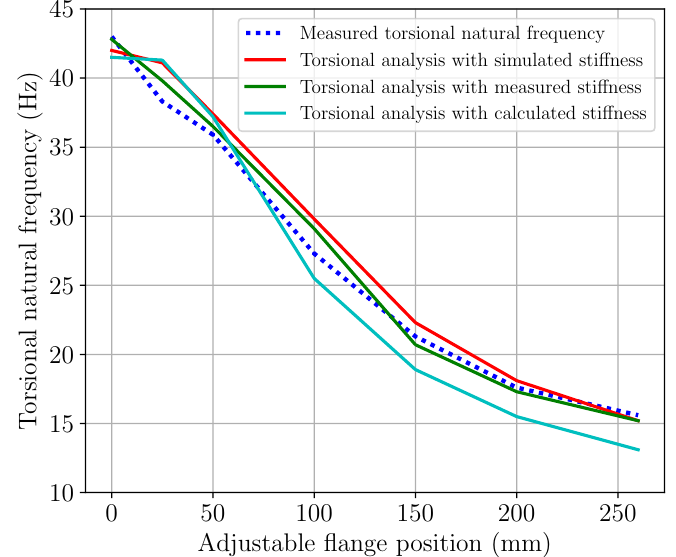
Figure 6. Comparison of torsional natural frequencies determined by measurements and torsional analysis. In the torsional analysis, the adjustable coupling was represented with torsional stiffness values determined by analytical calculations, FEM simulation and experimental